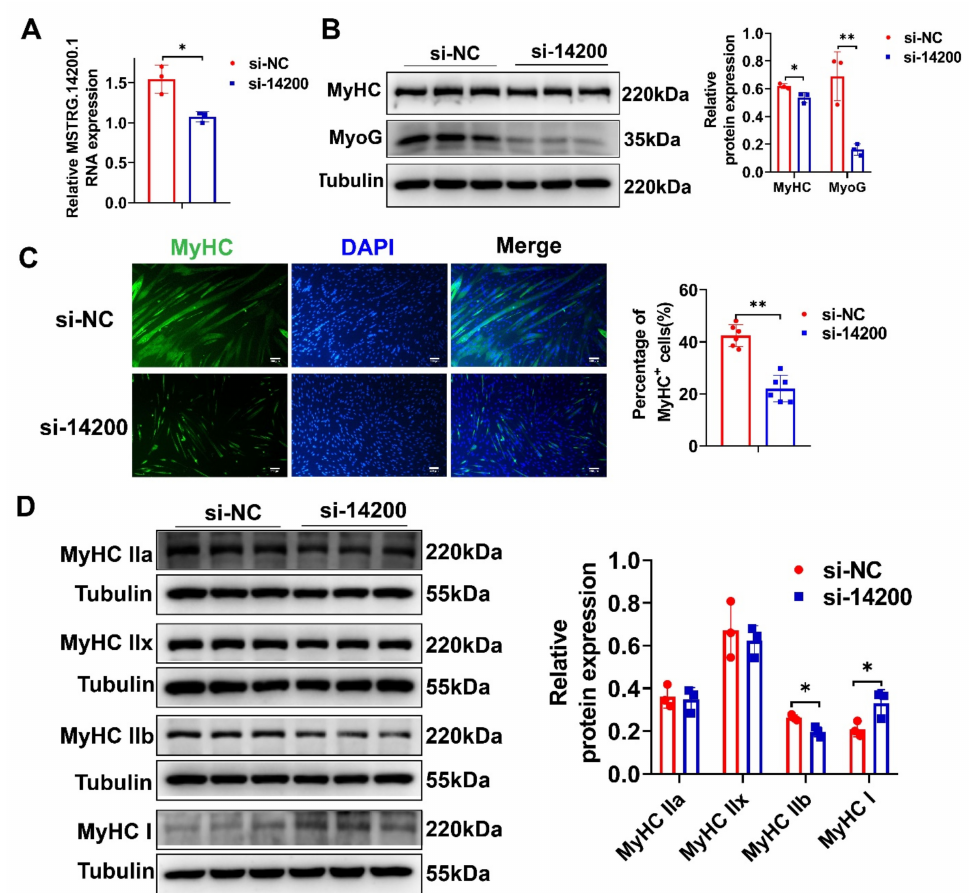
Figure 8. Inhibition of MSTRG.14200.1 reduced PSC differentiation and stimulated fast-to-slow muscle-fiber conversion. ( A ) qPCR result showed that MSTRG.14200.1 expression was significantly reduced. ( B ) Western blotting result showed that the protein expression levels of MyoG and MyHC were remarkably decreased after MSTRG.14200.1 knockdown. ( C ) Immunofluorescence staining result of MyHC showed that knockdown of MSTRG.14200.1 significantly reduced the proportion of MyHC + cells. Scale bar: 200 µ m. ( D ) Western blotting result showed that MSTRG.14200.1 knockdown notably inhibited MyHC IIb protein expression and enhanced MyHC I protein expression. The relative RNA and protein expression were standardized to that of the control gene β -actin and Tubulin, respectively. Data represent mean ± SD of three independent biological replicates. * p < 0.05; ** p <